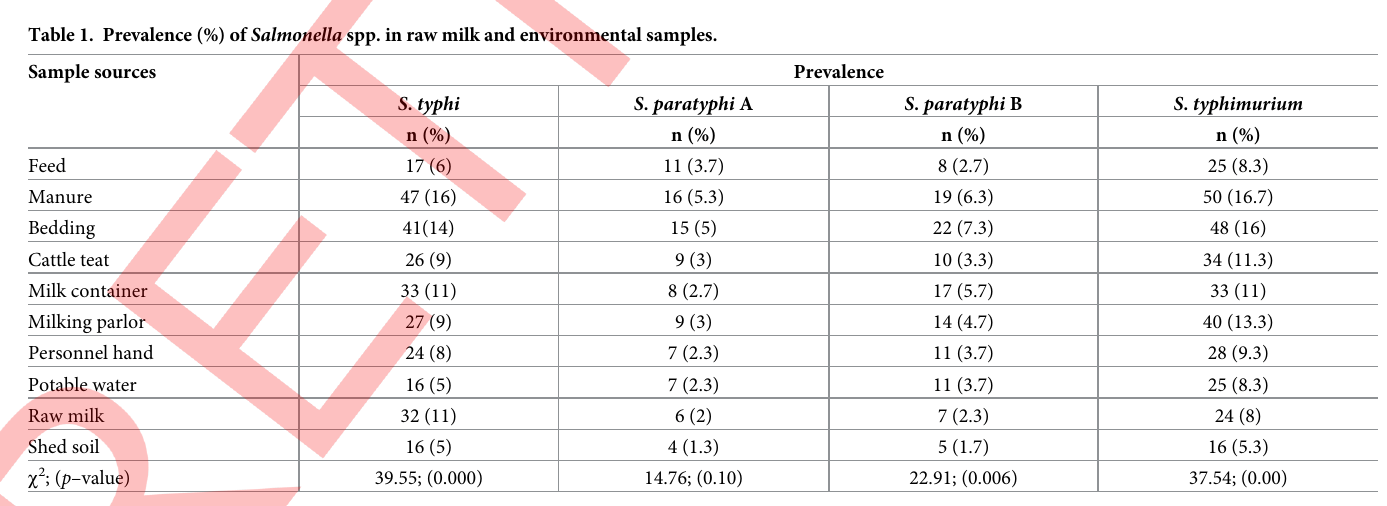
Table 1. Prevalence (%) of Salmonella spp. in raw milk and environmental